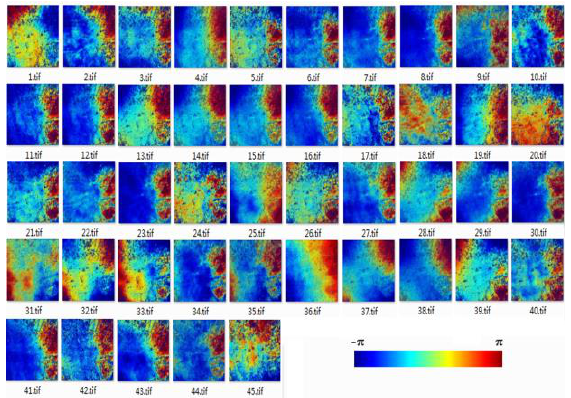
Figure 8. Unwrapping phase pictures